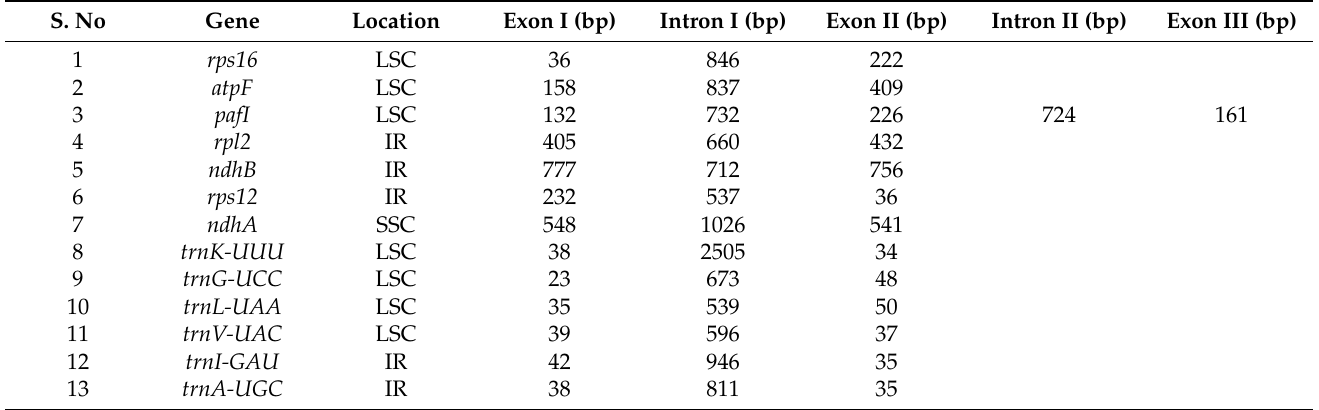
Table 2. The introns in the genes of the D. farinosus cp